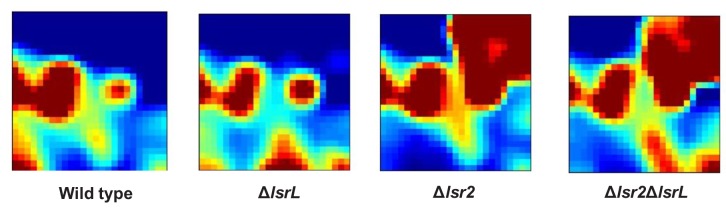
Differential metabolic phenotype heat map for wild type, lsr2, lsrL and lsr2/lsrL mutant strains.Methanol extracts from triplicate cultures were analyzed by LC/MS. The resulting peaks were averaged and the medium control was subtracted. All metabolites were then compiled into the self-organizing metabolic maps shown here. Red: most abundant; blue: least abundant.